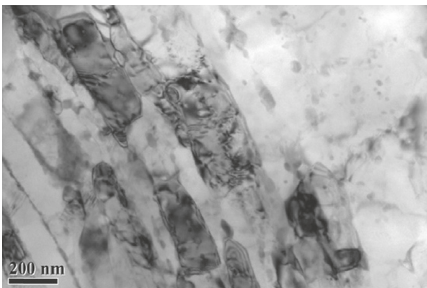
Figure 5: TEM imaging of elongated subgrains in a cold-sprayed Al 7075 particle